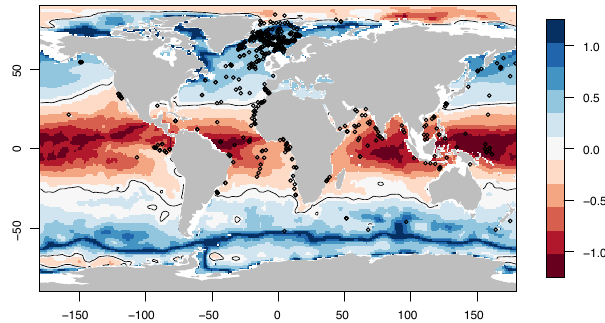
Figure 1. Distribution of core top δ 18 O data used in this study. Background colours represent the log 10 ratio of the temperature range at the surface to the temperature range in the annual mean val- ues between 0 and 200m depth. Blue colours indicate areas where seasonal temperature gradients are larger than vertical gradients and red colours indicate the opposite. The thin black contour line shows the zero level of this